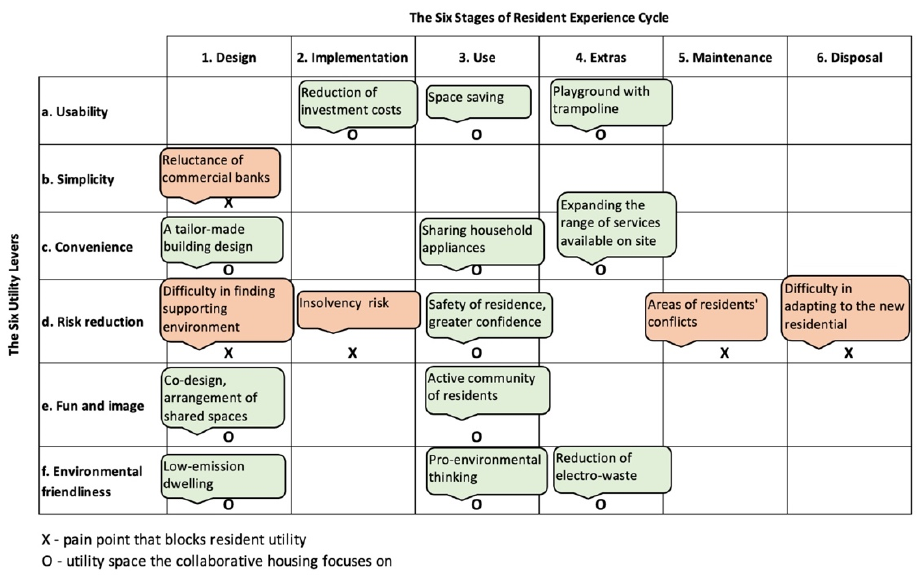
Figure 1. The residents’ utility map of collaborative housing in Poland.